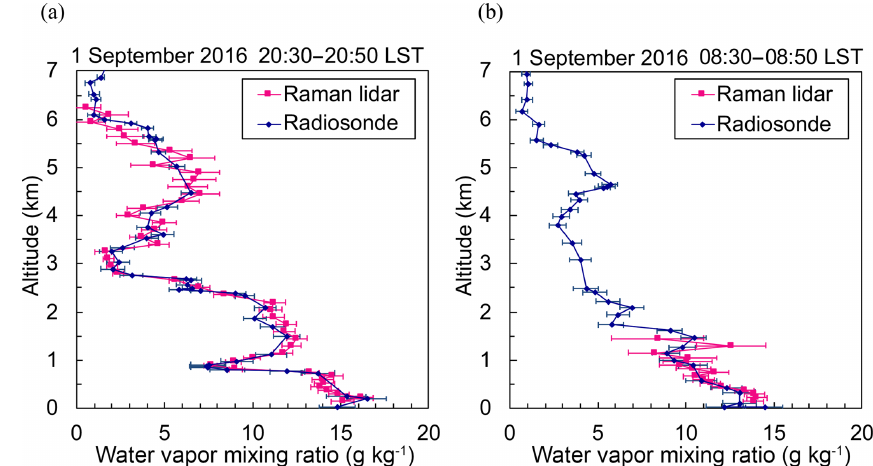
Figure 6. Vertical distributions of the water vapor mixing ratio obtained with the MRL (magenta) and radiosonde (dark blue) on 1 Septem- ber 2016 over Tsukuba. The measurement periods for the MRL were (a) 08:30–08:50 and (b) 20:30–20:50LST, and the radiosondes were launched at (a) 08:30LST and (b) 20:30LST. MRL data with uncertainty of less than 30% are plotted.